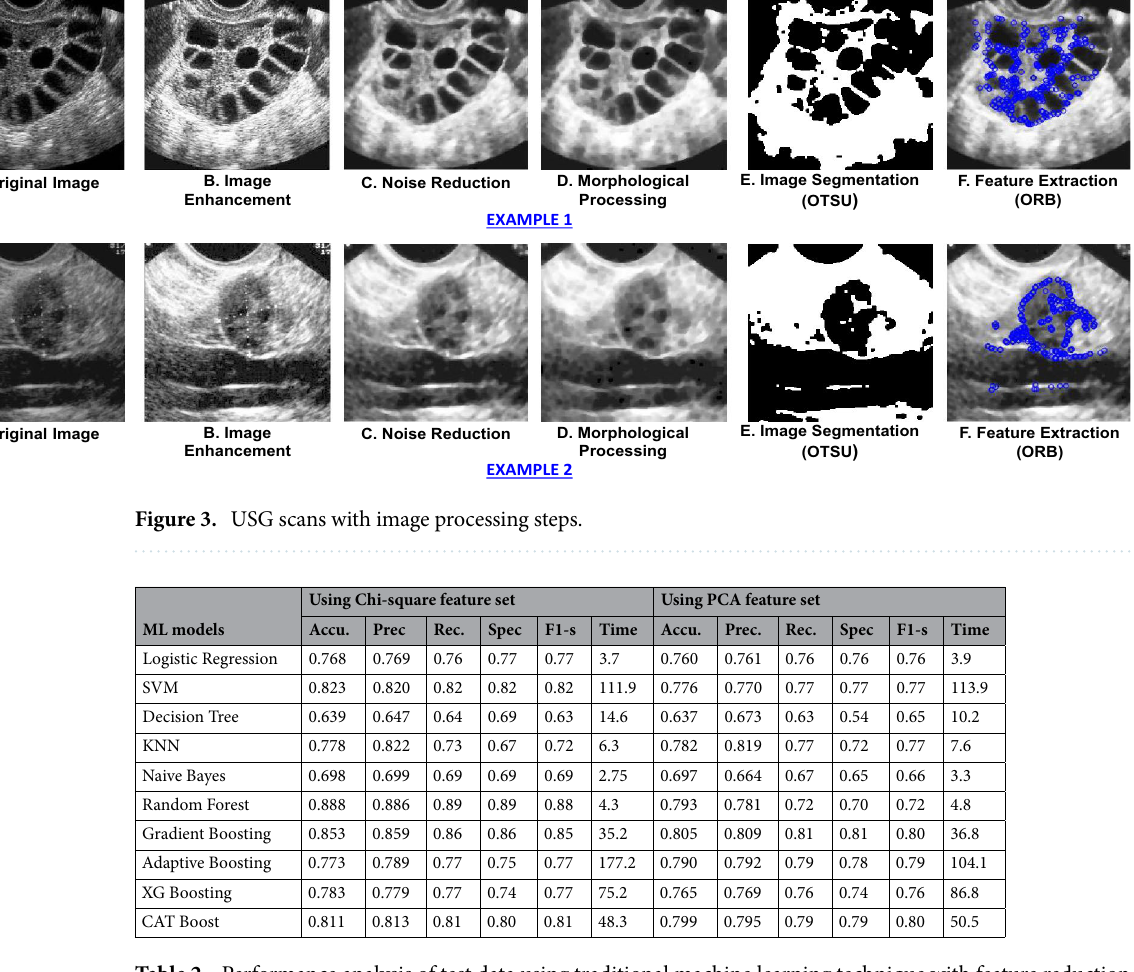
Table 2. Performance analysis of test data using traditional machine learning technique with feature reduction (Technique